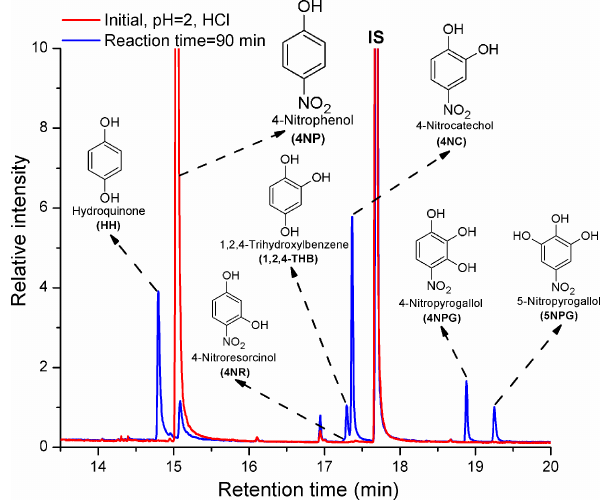
Figure 1. GC/MS chromatogram illustrating the formation of phe- nols from Reaction (R1) at pH =